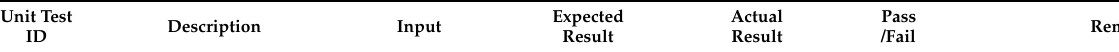
Table A2. Unit testing cases of showing a 3D model of one use of the chemical element.